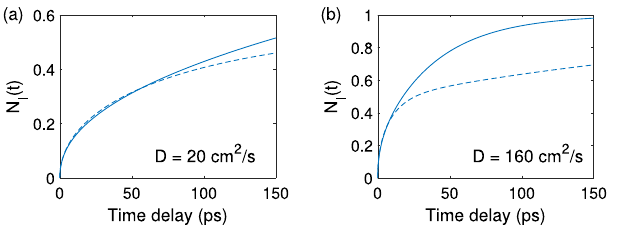
Figure 5. The total number of photoelectrons N I ( t ) transported from the AL into the BBR, predicted by the SDM (solid) and the GDM (dashed), with ( a ) D = 20 cm